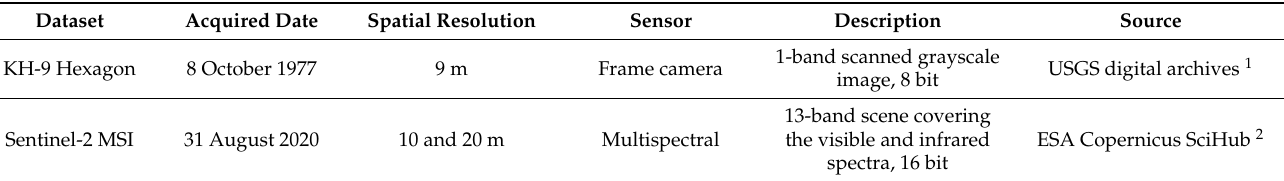
Table 1. Remote sensing datasets used in the analysis.